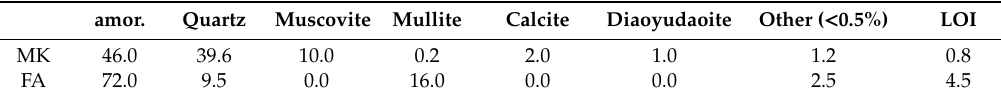
Table 1. Amorphous amount (amor.), main crystalline phases and loss on ignition (LOI) of metakaolin (MK) and fly ash (FA).